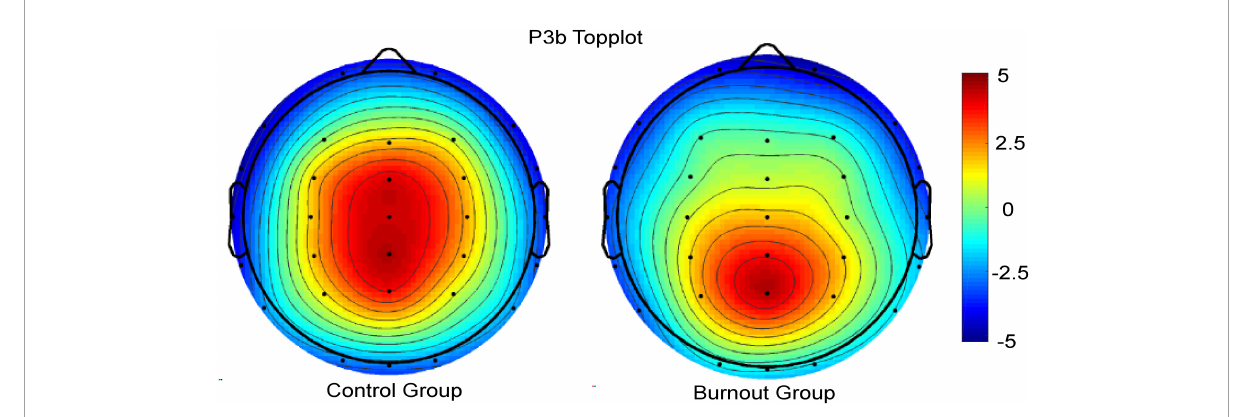
FIGURE7 Brain topographic map of P3b in the burnout group and control